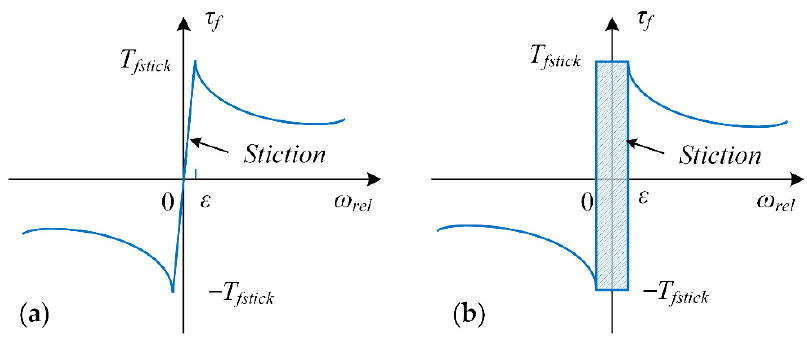
Figure 6. Static friction model: ( a ) classical model, and ( b ) Karnopp model.